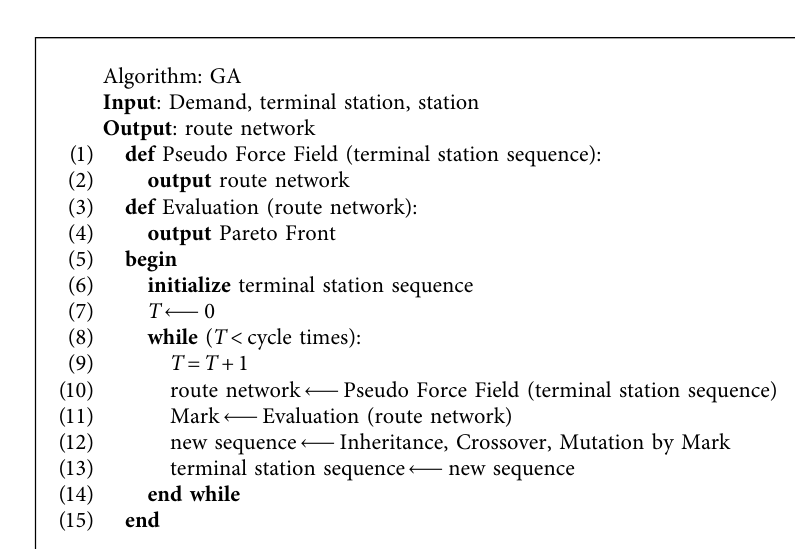
Figure 8: Crossover in GA.